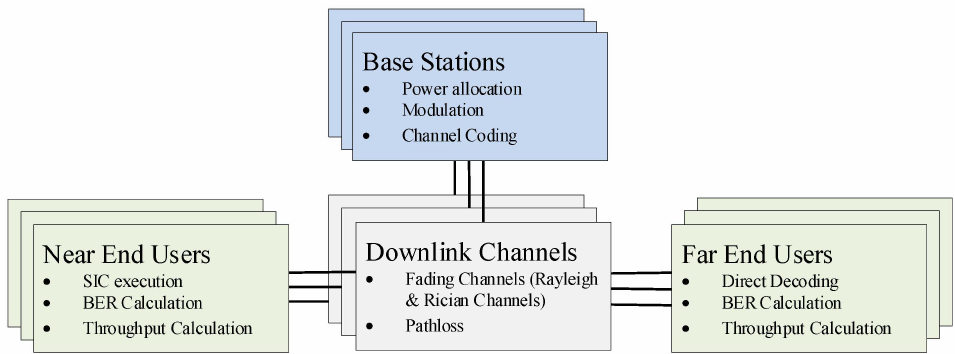
Figure 4. Structure for implementation of a link to system-level Simulator.